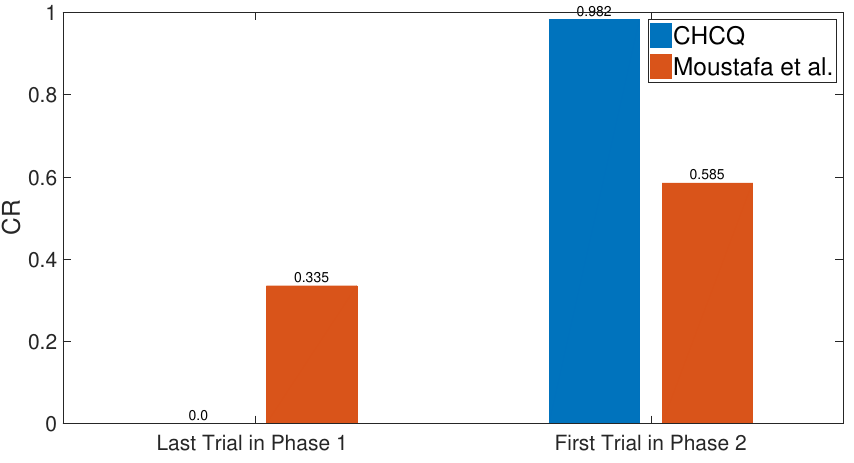
Figure 35. Context shift due to latent inhibition task for the intact